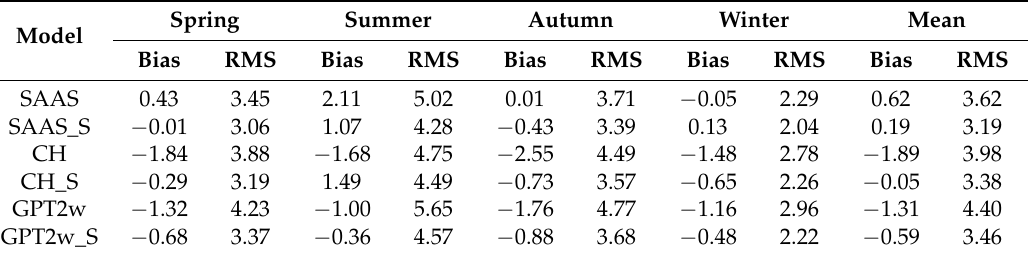
Table 3. Statistical data for various tropospheric models in different seasons (unit: cm). Model